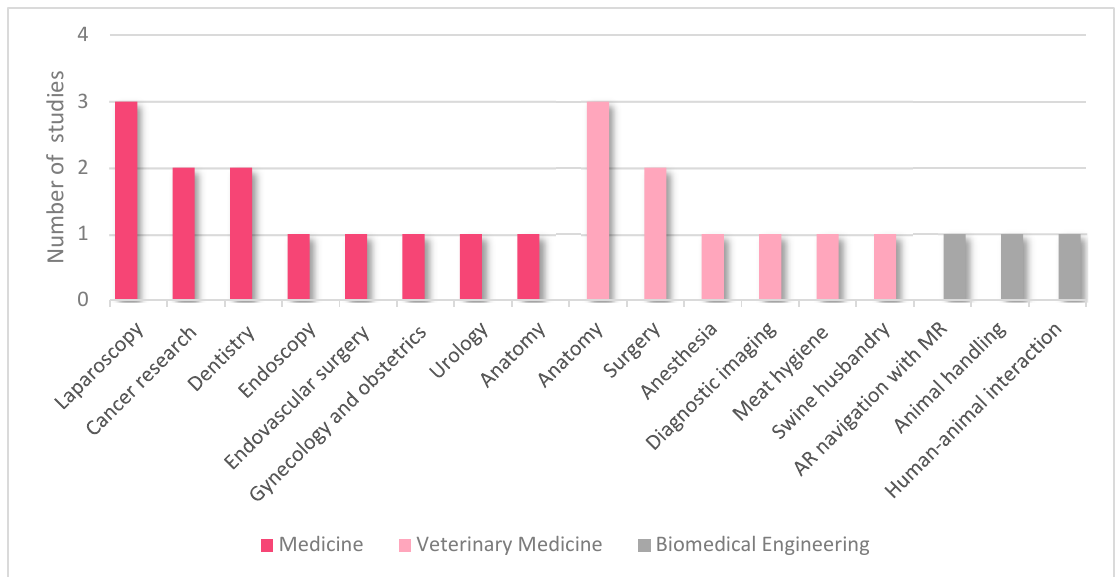
Figure 3. Illustration of included articles per topic. AR: augmented reality; MR: magnetic resonance imaging; US: ultrasonography.